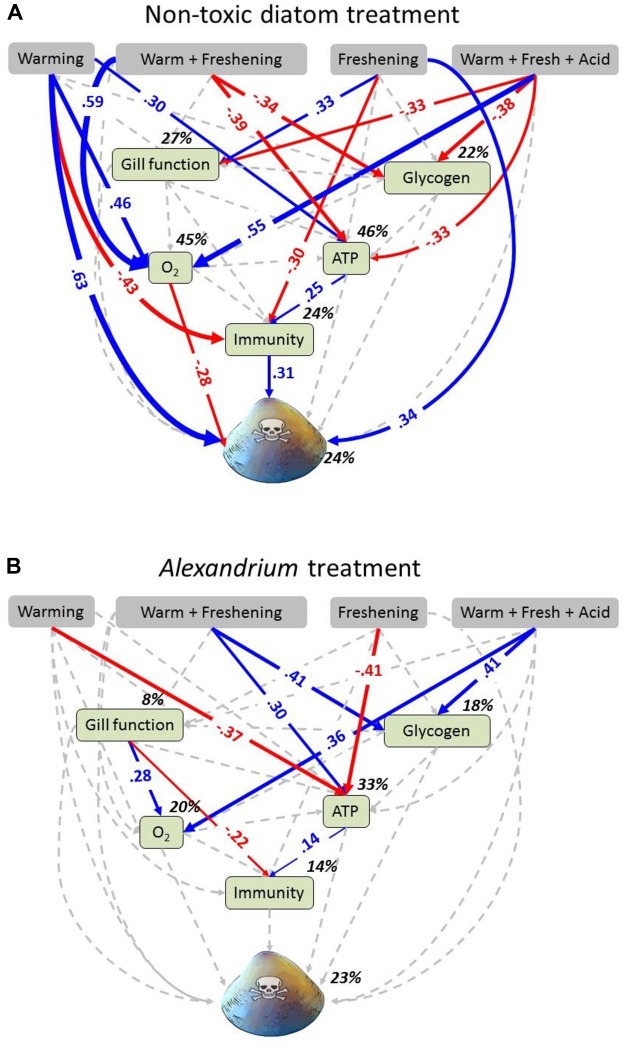
Path diagrams showing the interactive effects of exposure to food source and simulated climate change effects on toxin concentration in Meretrix meretrix. Path diagrams showing how experimental warming, freshening and the interaction between warming and freshening and warming, freshening and acidification affect the gill function, glycogen, oxygen consumption (O2), ATP concentration, immunity and toxin concentration. Path diagrams represent (A) clams fed with non-toxic diatoms (Thalassiosira weissflogii) and, (B) clams fed with Alexandrium minutum. Solid paths (blue and red) are (positively and negatively) statistically significant (P < 0.05) whereas the dashed gray lines are not. Note that a positive effect on “toxicity” results in an increased toxicity level within the clams, whereas a negative effect results in a decreased toxicity level. At each significant path the standardized coefficients are represented and interpreted as follows: If, for example, temperature goes up by 1 SD during A. minutum exposure, the ATP concentration of clams goes down by 0.37 SD. Percentages indicate the variance explained by the model. Samples sizes (n = 16) but see Supplementary Table 2.